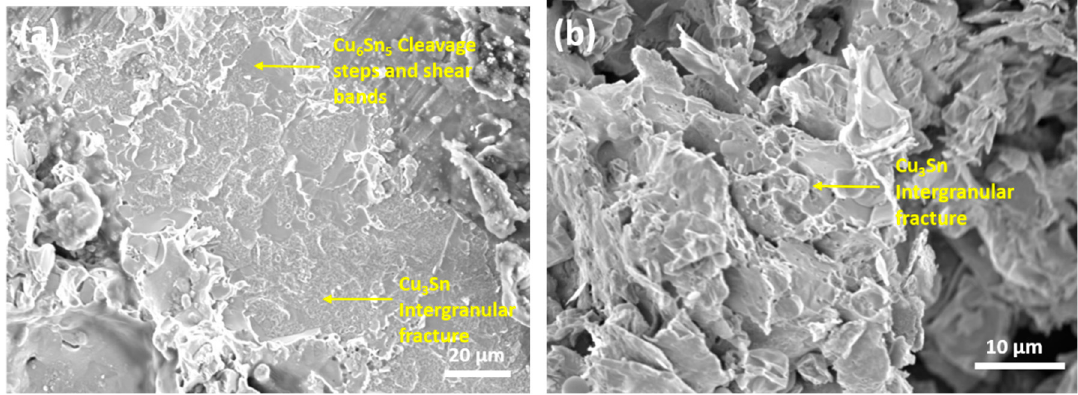
Figure 6. Fracture surfaces of the Cu/Sn-Cu-MWCNT/Cu joint for different reflow times ( a ) 5 min and ( b ) 8